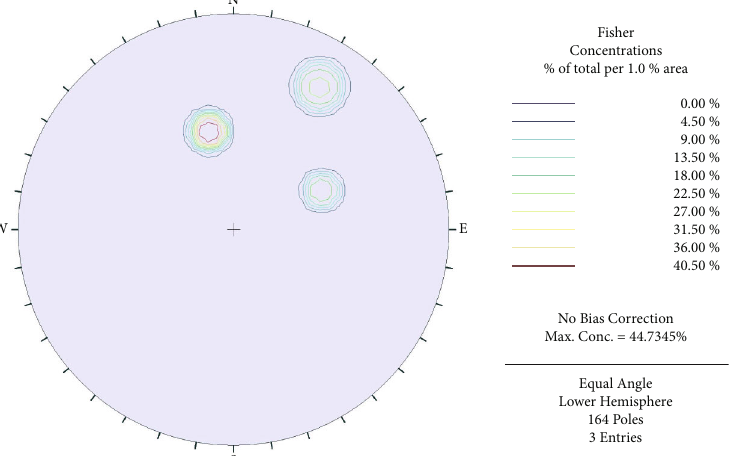
Figure 8: The pole contour of the dominant structural plane based on the FCM